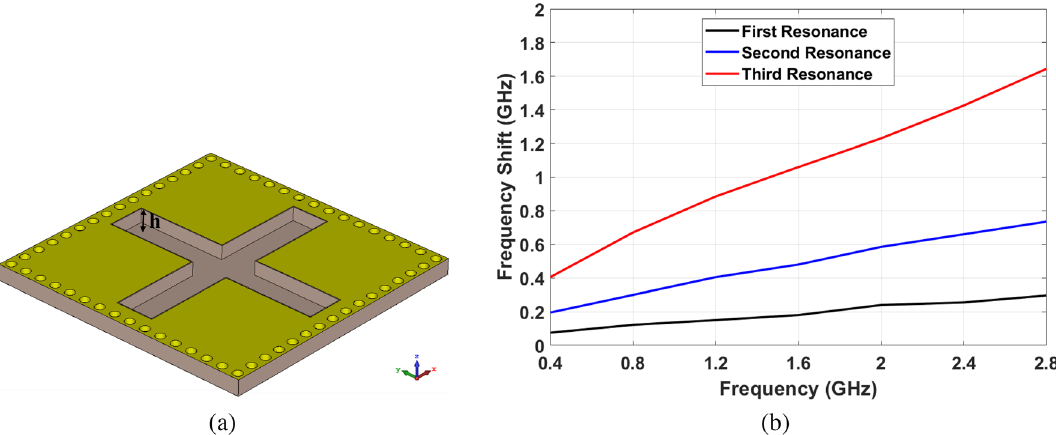
Figure 11. ( a ) Final unit cell after etching the channels , ( b ) The frequency shift by changing the soil moisture content from 0% to 30% for different depth of channels.